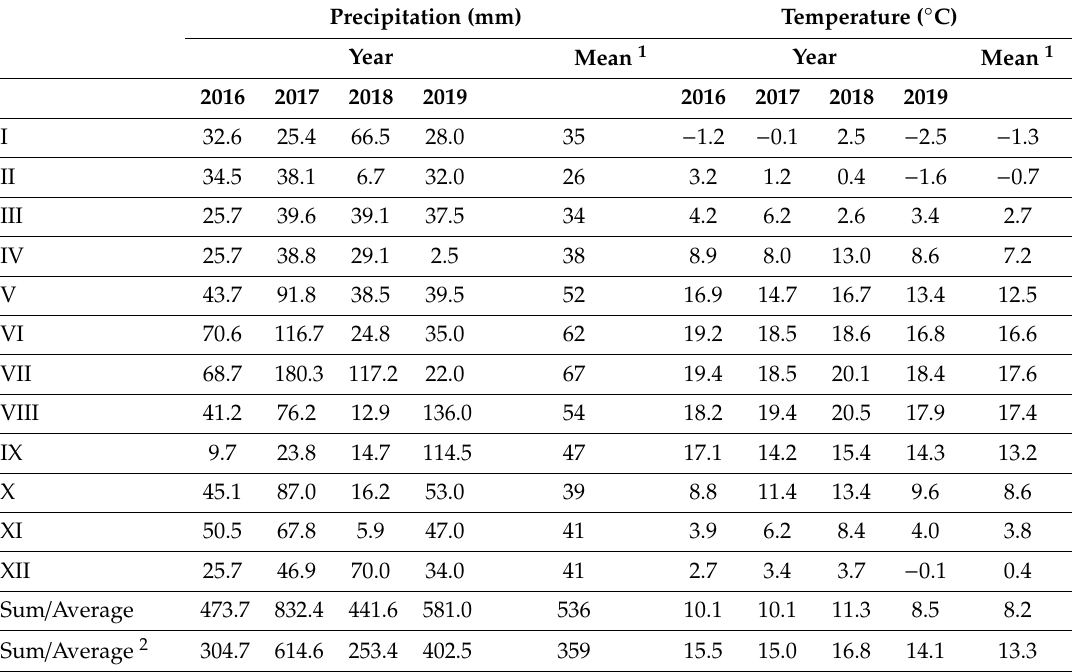
Table 2. Monthly sum of precipitation (mm) and monthly average air temperature ( ◦ C) at AES Lipnik in 2016–2019 and in multi–year